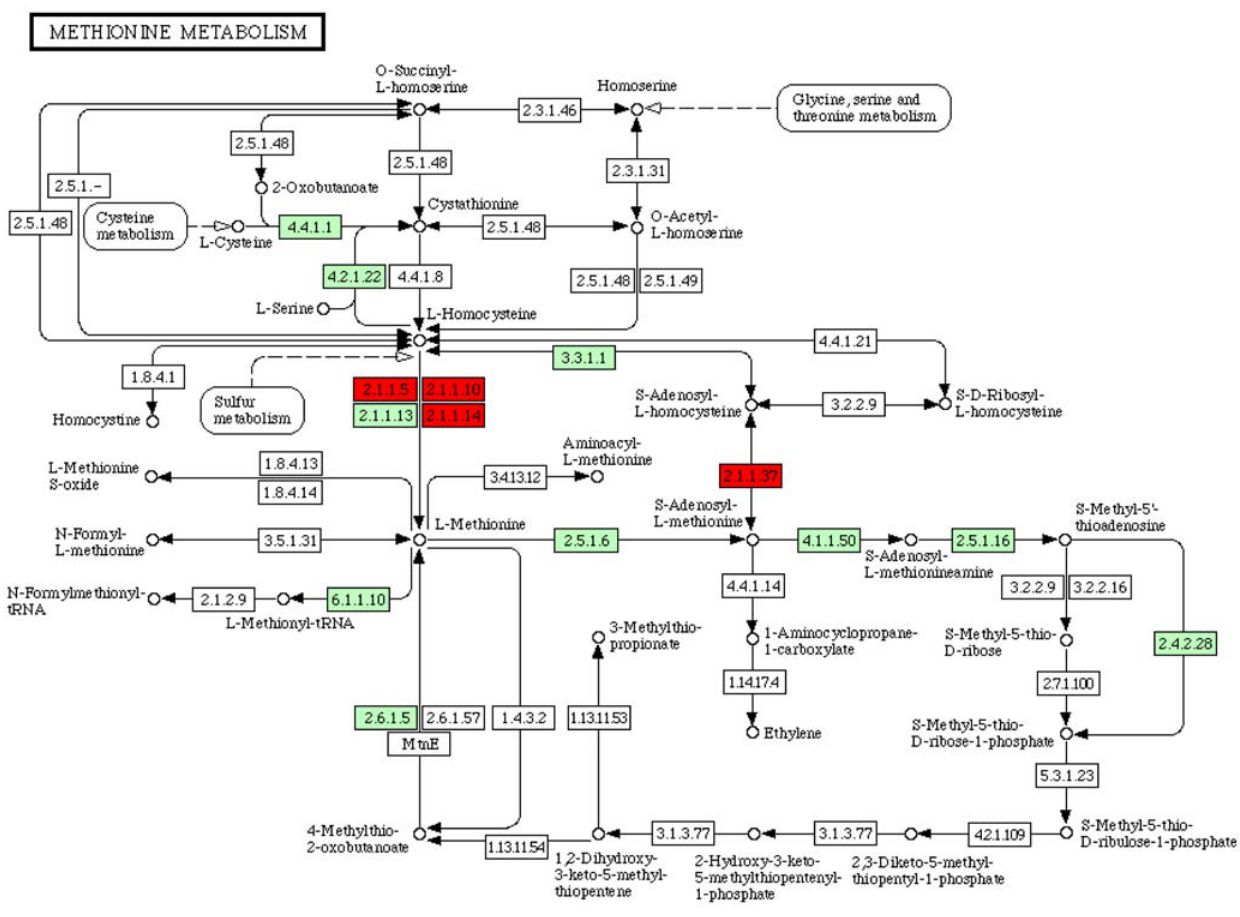
Figure 4. Methionine metabolism in nematodes. Cytosine-5 9 -methyltransferase (EC 2.1.1.37) is not present in C. elegans but has been detected in four phylogenetically divergent nematode species, suggesting that it may be widespread throughout the phylum and lost in the Caenorhabditis lineage. Enzymes found in C. elegans are green, those present in other nematodes but absent in C. elegans are red. Three further enzymes were identified as possible candidates for gene loss in C. elegans. Betaine-homocysteine S-methyltransferase (EC 2.1.1.5), homocysteine S-methyltransferase (EC 2.1.1.10) and 5-methyltetrahydropteroyltriglutamate–homocysteine methyltransferase (EC2.1.1.14) were found in one, seven and four nematode species, respectively, but not in C. elegans . The latter two enzymes have not previously been reported in metazoans and their identification in plant- parasitic nematodes may be a result of horizontal gene transfer.